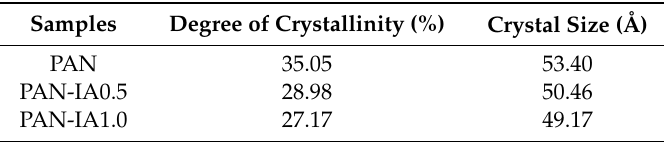
Table 2. X-ray Di ff raction (XRD) parameters of PAN homopolymer, PAN-IA0.5 copolymers, and Table 2. X-ray Diffraction (XRD) parameters of PAN homopolymer, PAN-IA0.5 copolymers, and PAN-IA1.0 PAN-IA1.0 copolymers.